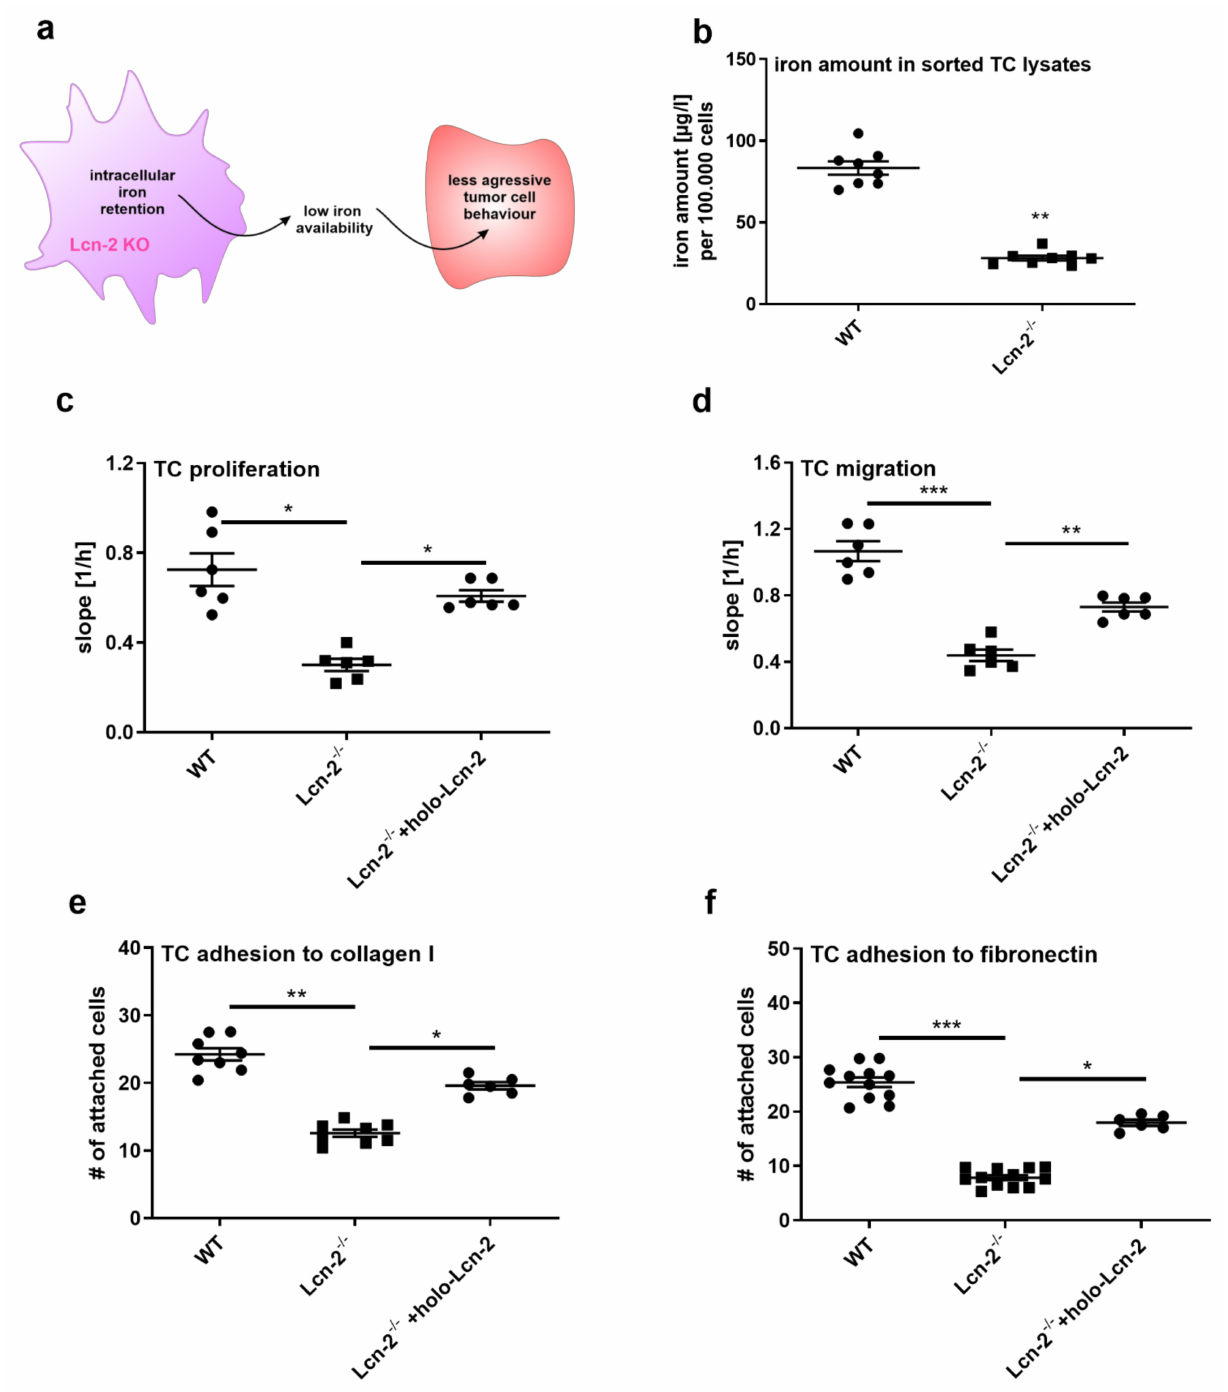
Figure 4. Lcn-2 − / − tumor cells are less aggressive and have reduced intracellular iron. ( a ) Tumor cells from Lcn-2 − / − (Lcn-2 − / − TC) mice show reduced growth and metastatic potential due to lower iron availability in the TME due to iron sequestration in Lcn-2 − / − TAM. ( b ) Measurement of the intracellular iron amount in tumor cells (TC) from WT and Lcn-2 − / − PyMT tumors. ( c – f ) Analysis of the tumor behavior in terms of ( c ) proliferation, ( d ) migration and ( e , f ) matrix adhesion, showing a less aggressive tumoral capacity of Lcn-2 − / − compared to WT tumor cells (TC). Applying recombinant iron-loaded (holo)-Lcn-2 (1 µ g/mL) for 24 h rescued proliferation, migration, and matrix adhesion in Lcn-2 − / − tumor cells. Graphs are displayed as means ± SEM. Statistically significant differences were calculated after analysis of variance (ANOVA) and Students t -test, with * p < 0.05, ** p < 0.01, *** p <